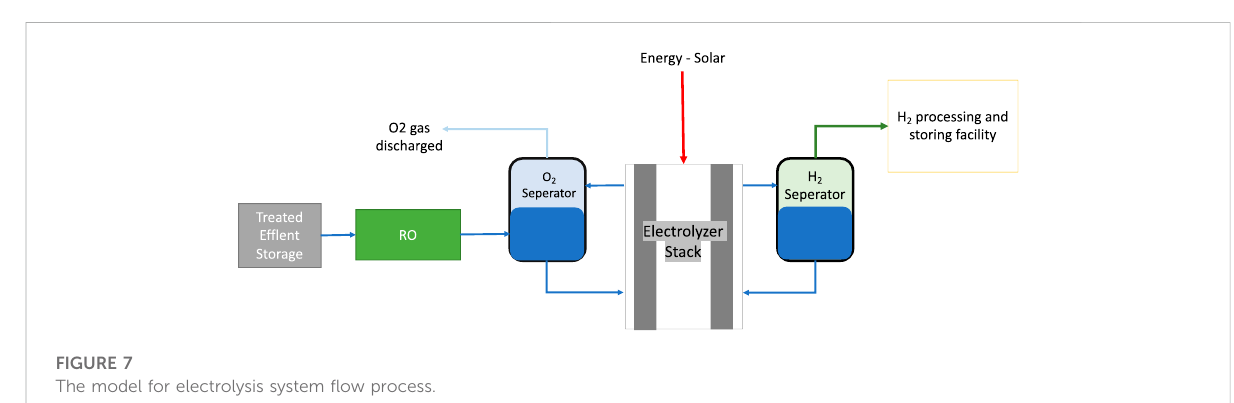
FIGURE 7 The model for electrolysis system fl ow